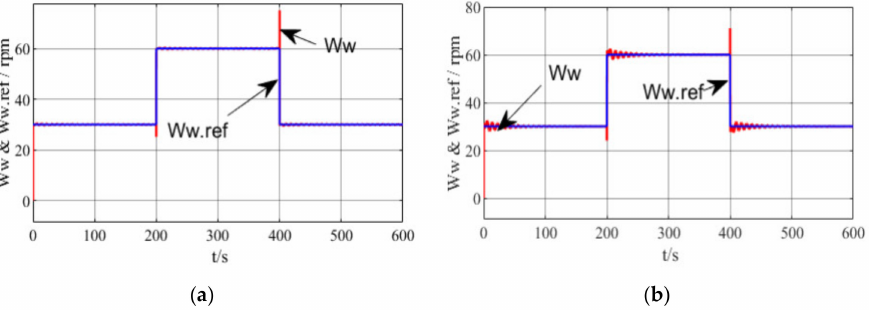
Figure 17. While α alter, the wind turbine speed waveform of PID control based on IMC and experiment scheme 2. ( a ) The speed waveform of α = 10; ( b ) The speed waveform of α =